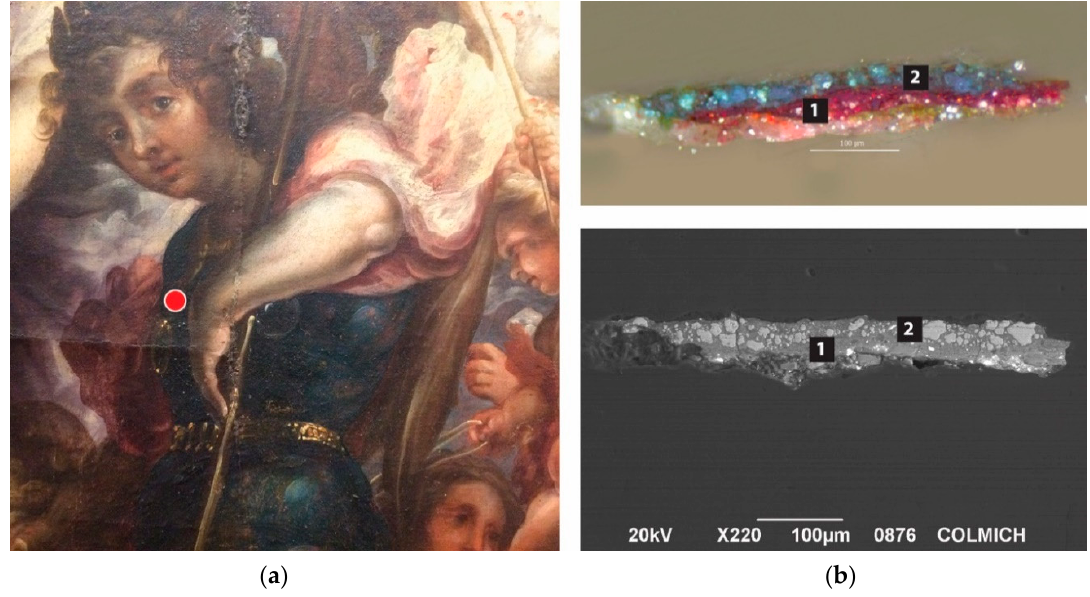
Figure 7. ( a ) Detail of the angel’s blue garment in El Triunfo de la Iglesia . The area where the sample was taken from is marked with a red dot. Detail of photograph by: Gerardo Hernández Rosales. Reproduction authorized by the Instituto Nacional de Antropología e Historia. ( b ) The cross-section under an optical microscope (20×) ( top ) and the SEM image (220×) ( bottom ). Images by LADiPA-COLMICH.